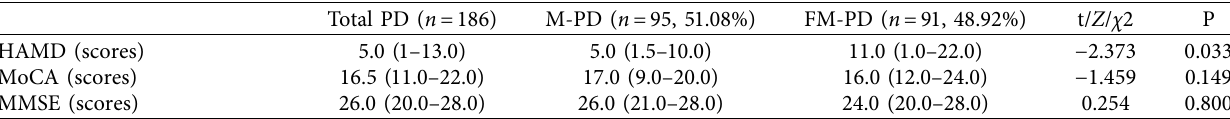
PD: Parkinson’s Disease; M-PD: male patients with PD; F-PD: female patients with PD; TD: tremor-dominant subtype; AR: akinetic-rigid subtype; mixed: mixed subtype; H&Y: Hoehn-Yahr stage; UPDRS -I: United Parkinson’s Disease Ranking Scale Part-I; UPDRS III: United Parkinson’s Disease Ranking Scale part-III; PSQI: Pittsburgh Sleep Quality Index; ESS: Epworth Sleepiness Scale; RBD: Rapid Eye Movement (REM) Sleep Behavior Disorder; RLS: Restless Legs Syndrome; HAMA: Hamilton’s Anxiety Scale; HAMD: Hamilton’s Depression Scale; MMSE: Minimental State Examination; MoCA: Montreal Cognitive Assessment. Table 4: Logistic Regression analysis of symptoms associated with gender in patients with